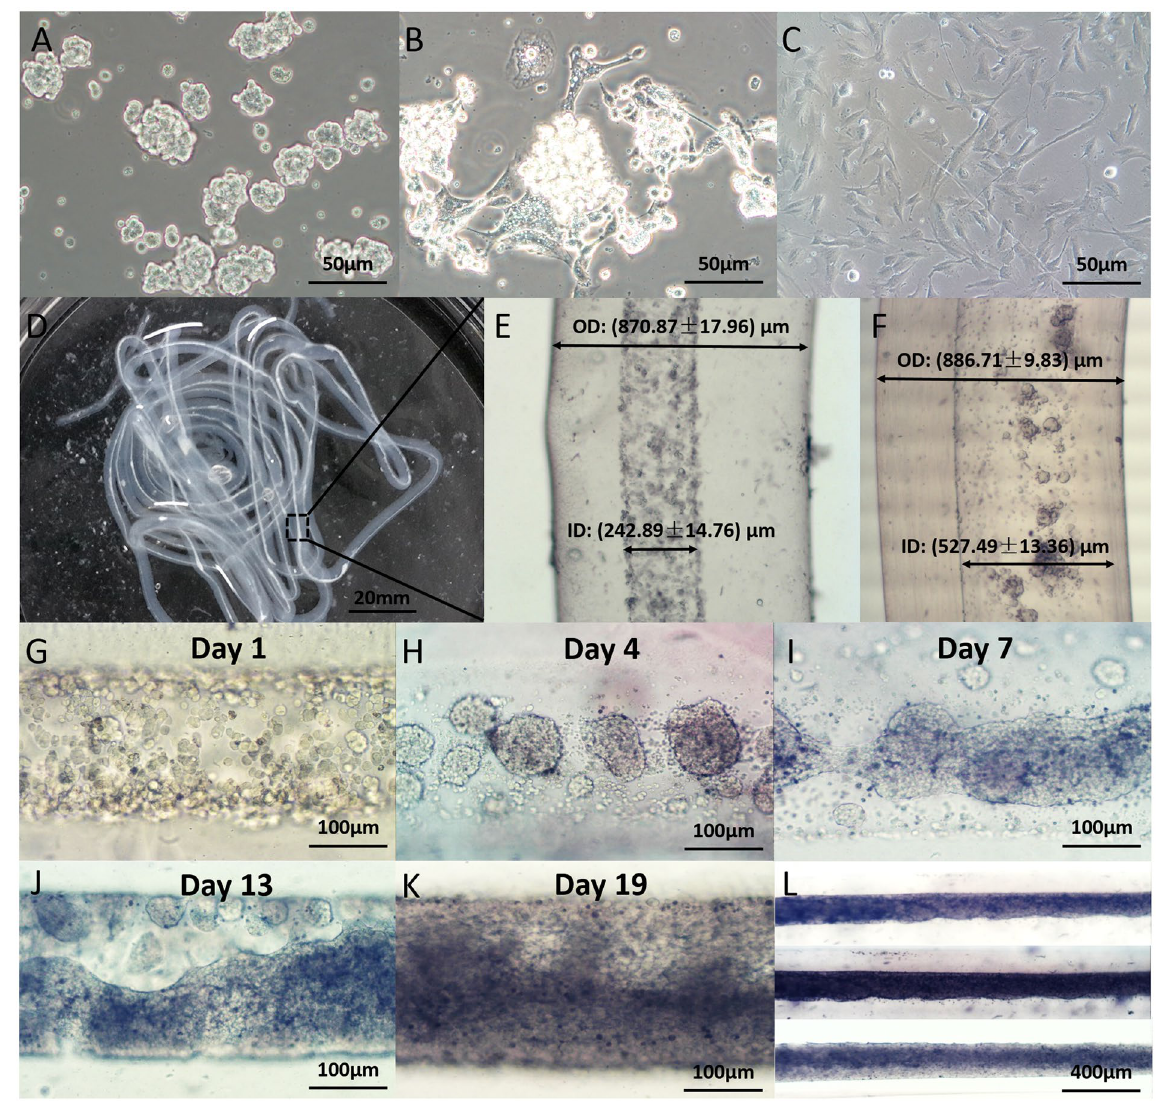
Figure 3. 3D core-shell cell fibers. ( A and B ) GSC23 grew in stem cell medium ( A ) and complete medium ( B ); C: MSCs cultured in complete medium; D: Coaxial 3D bioprinted cell fibers; ( E and F ) Cell fiber with extrusion speed of 3 ml/h and 10 ml/h; ( G – L ) Coaxial 3D bioprinted tumor fiber cultured for 1, 4, 7, 13, and 19 days. Scale bars: ( A – C ) 50 μ m, ( D ) 20 mm, ( G – K ) 100 μ m and ( L ) 400 μ